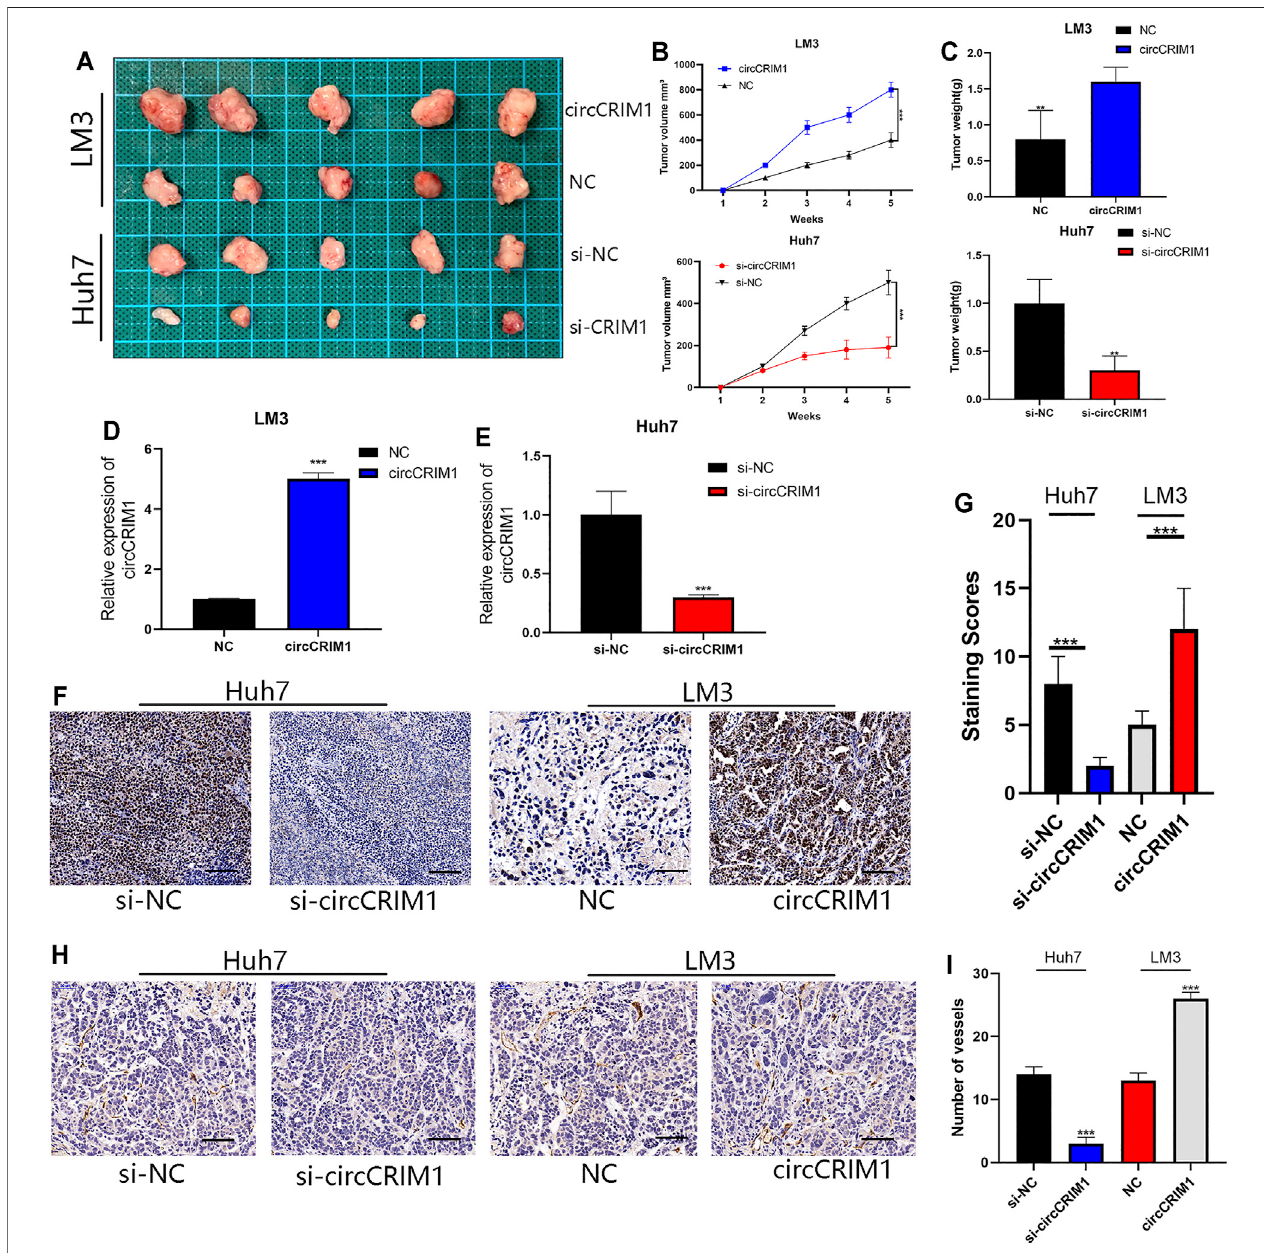
FIGURE 8 | CircCRIM1 promotes HCC xenograft growth in vivo . (A) Representative images of subcutaneous xenograft tumors ( n (cid:2) 5 for each group). (B) Growth curves for tumor volumes, which were measured every week. (C) Tumor weight analysis. (D,E) Expression of circCRIM1 was observed in mouse tumors from each group. (F,G) IHC staining of xenograft tumors. SKP2 protein levels were analyzed based on IHC staining. Scale bar, 25 μ m (H,I) Blood vessels were stained using anti- CD34 and positively stained vessels were counted in fi ve areas per slide to determine maximum number of micro-vessels, ten slides per experiment. Scale bar, 25 μ m. All data are presented as the means ± SD of three independent experiments. * p < 0.05, ** p < 0.01, *** p < 0.001, and **** p < 0.0001.